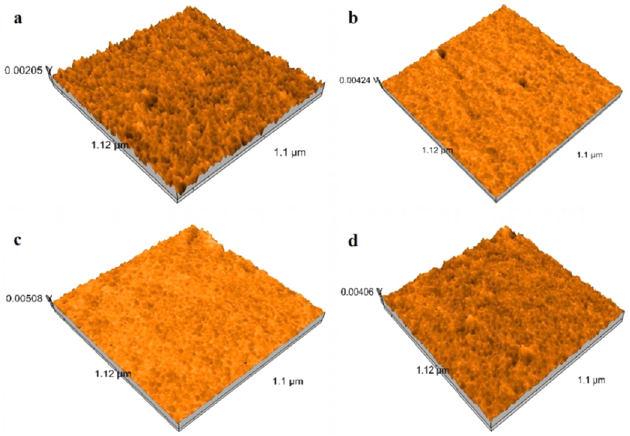
Fig. 4. The atomic force microscopy images of: (a) ZnTa 2 O 6 , (b) ZnNb 2 O 6 , (c) MgTa 2 O 6 and (d) MgNb 2 O 6